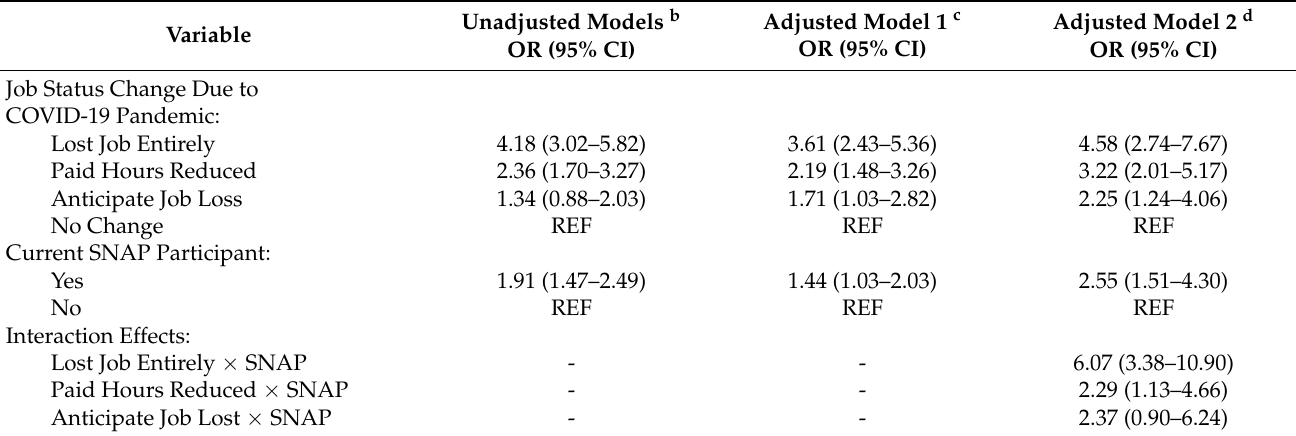
Table 3. Associations between Employment Status Change during Pandemic, SNAP Participation, and Very Low Food Security a .